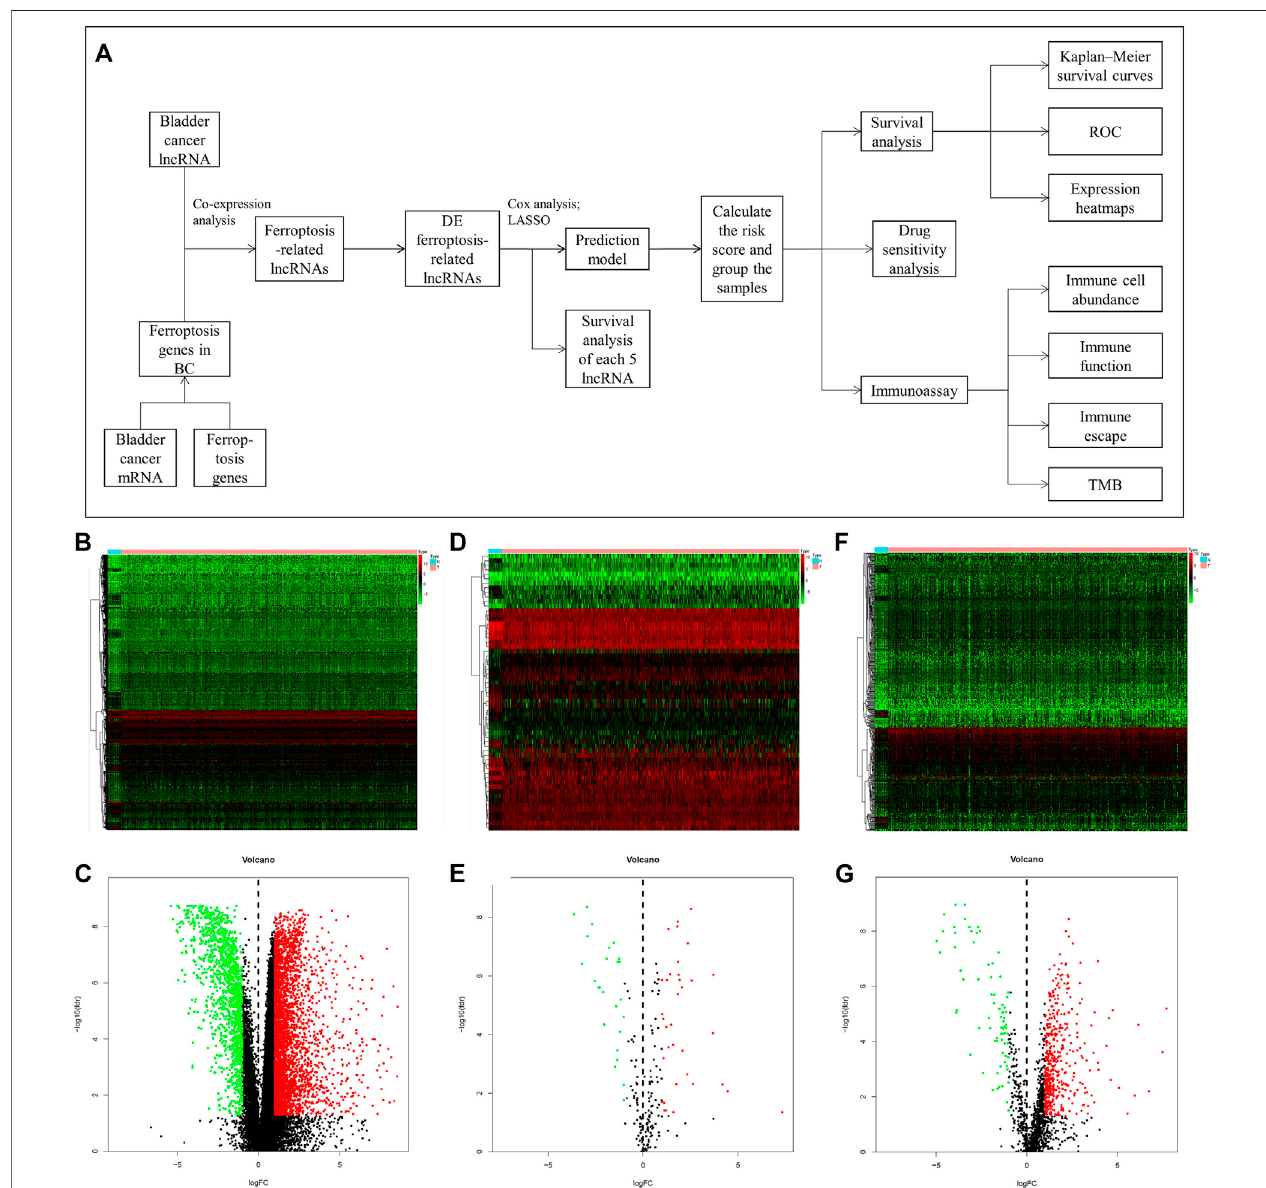
FIGURE 1 | The mentality of this study and comparison of gene expression between bladder tissue and adjacent normal tissue. (A) Flow chart of this research. Expression heatmaps of bladder cancer genes including mRNA and lncRNA (B) , ferroptosis genes (D) and ferroptosis-related lncRNAs (F) . Volcano plot of differentially expressed bladder cancer genes (C) , ferroptosis genes (E) and ferroptosis-related lncRNAs (G) between normal and tumor samples.